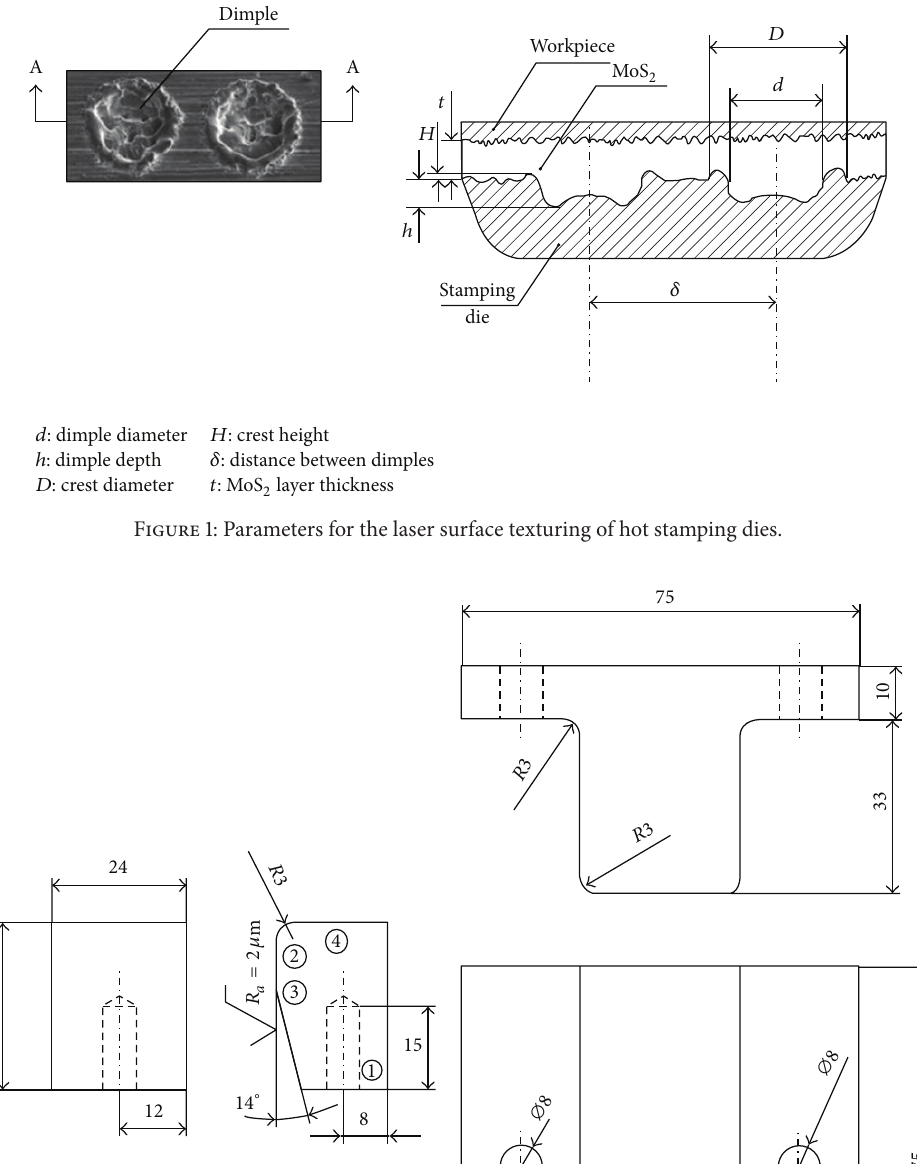
(iii) the dimple depth ( ℎ ) added to the height of the crest ( 𝐻 ) must be less than the diameter of the crest ( 𝐷